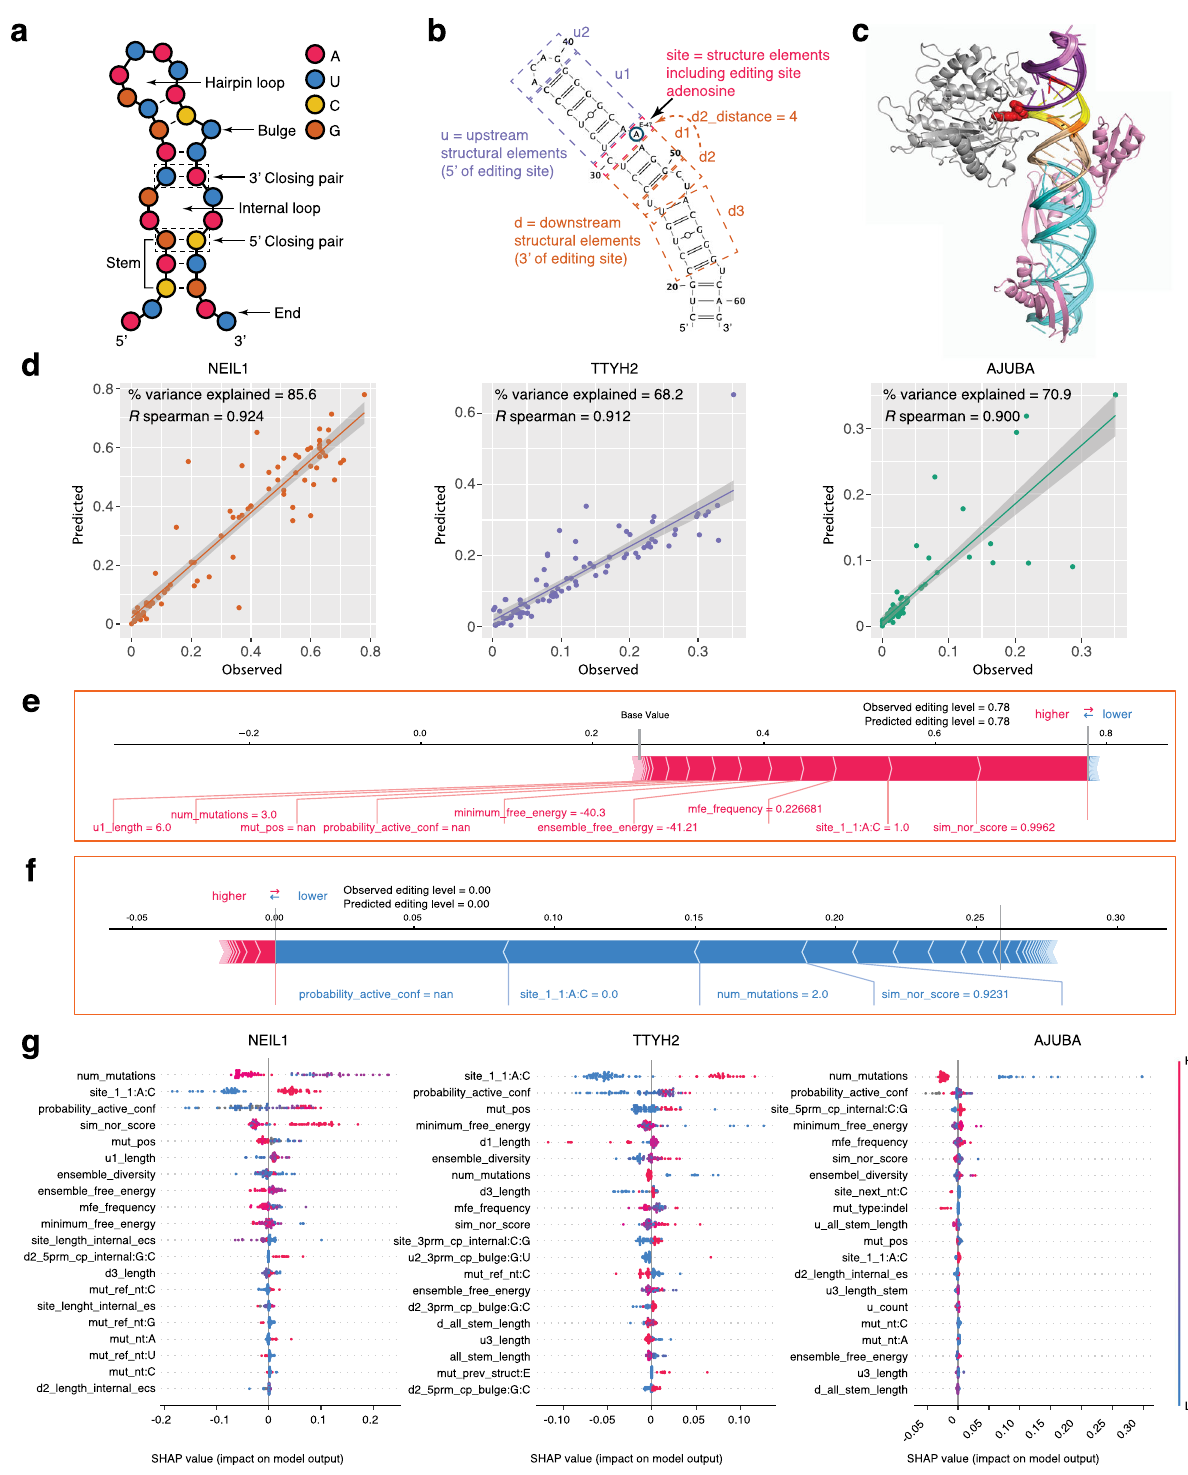
Next, we tested whether models trained on variants of one or more substrates could predict editing effects of mutations in a different substrate. We observed a signi fi cant drop in model performance for cross-substrate prediction of RNA editing (Supplementary Fig. 11,). For example, a model trained on NEIL1 variants yielded lower performance on AJUBA variants ( R 2 < 0.05, R s = 0.68, auPR = 0.69) and TTYH2 variants ( R 2 < 0.05, R s = 0.46, auPR = 0.59), as compared to a model trained and tested on NEIL1 variants ( R 2 = 0.88, R s = 0.93, auPR =